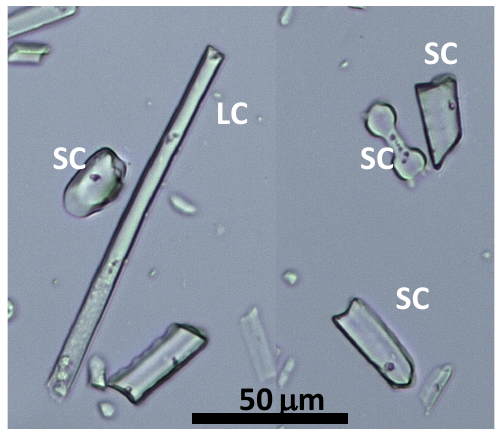
Figure 2. Growth chamber experiment: phytolith types extracted from Festuca arundinaceae and observed in natural light mi- croscopy: epidermal long cell (LC), epidermal short cell (SC).